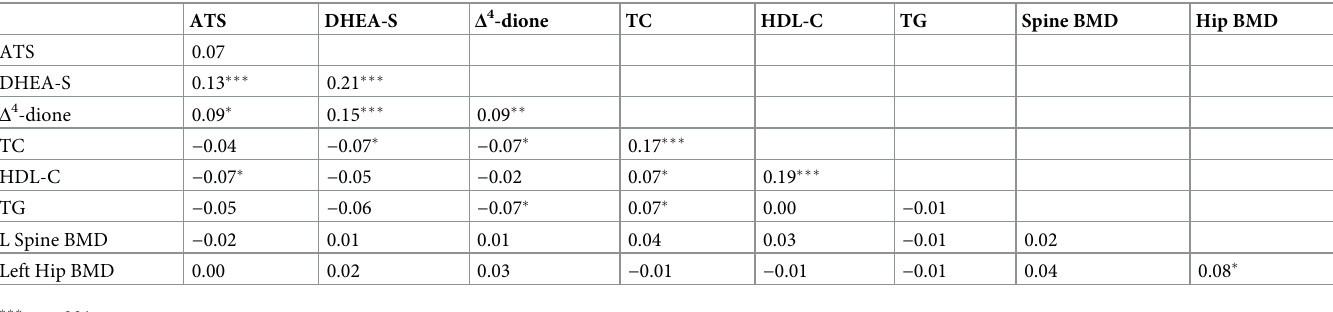
Table 3. Phenotypically standardized shared environmental variance